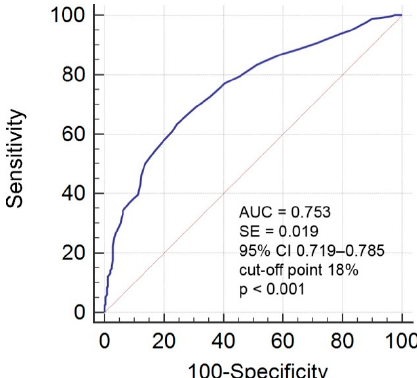
Figure 1. ROC curve analysis for SDF. Criterion variables are normal and abnormal standard semen parameters. AUC—area under the curve; ROC—receiver operating characteristic; SDF—sperm DNA fragmentation; p ≤ 0.05—statistical significance between obtained AUC vs. AUC = 0.5; CI 95%—95% confidence interval. The level of AUC was as follows: >0.7–0.8—satisfactory predictive value.